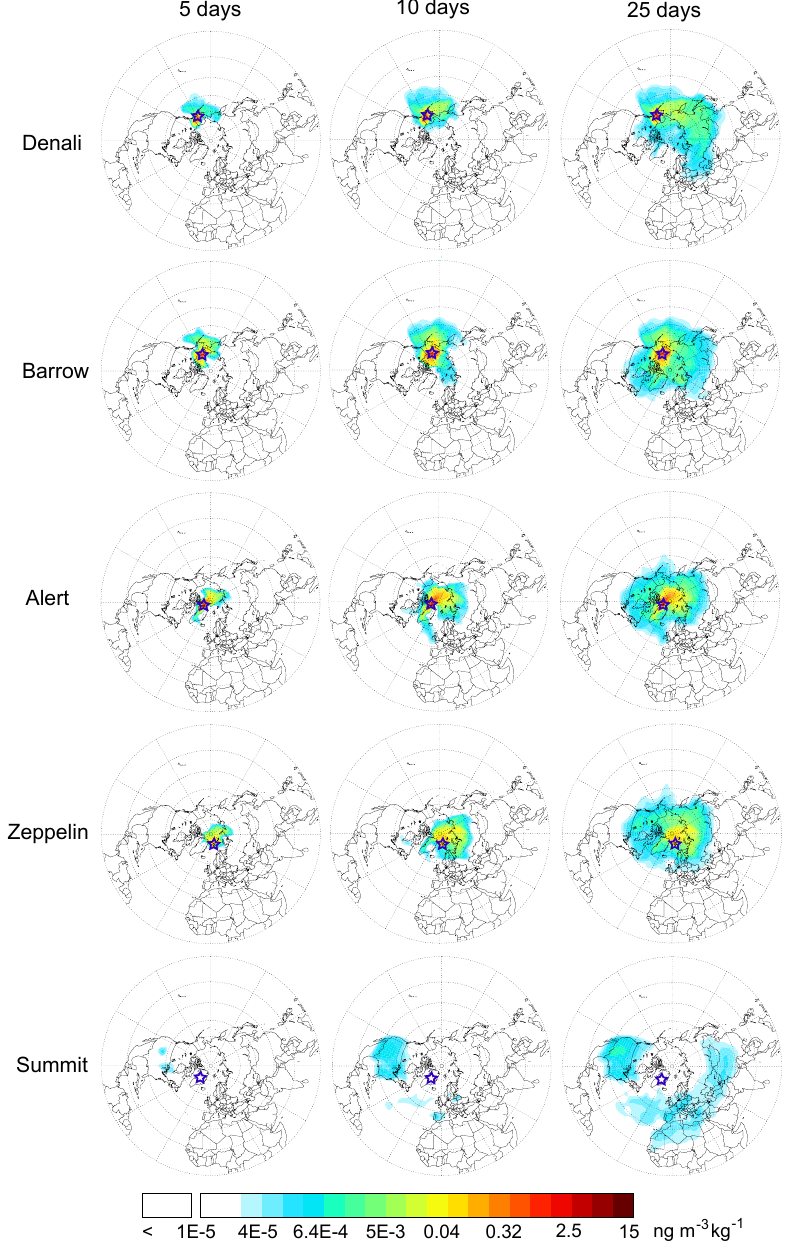
Figure 5. Sensitivity of mean BC concentration (averages for 20–25 April 2008) at Denali, Barrow, Alert, Zeppelin, and Summit (see Fig. 1) to Northern Hemisphere hypothetical unit BC emissions from during the 5, 10, and 25 days prior to 25 April. See text for details.